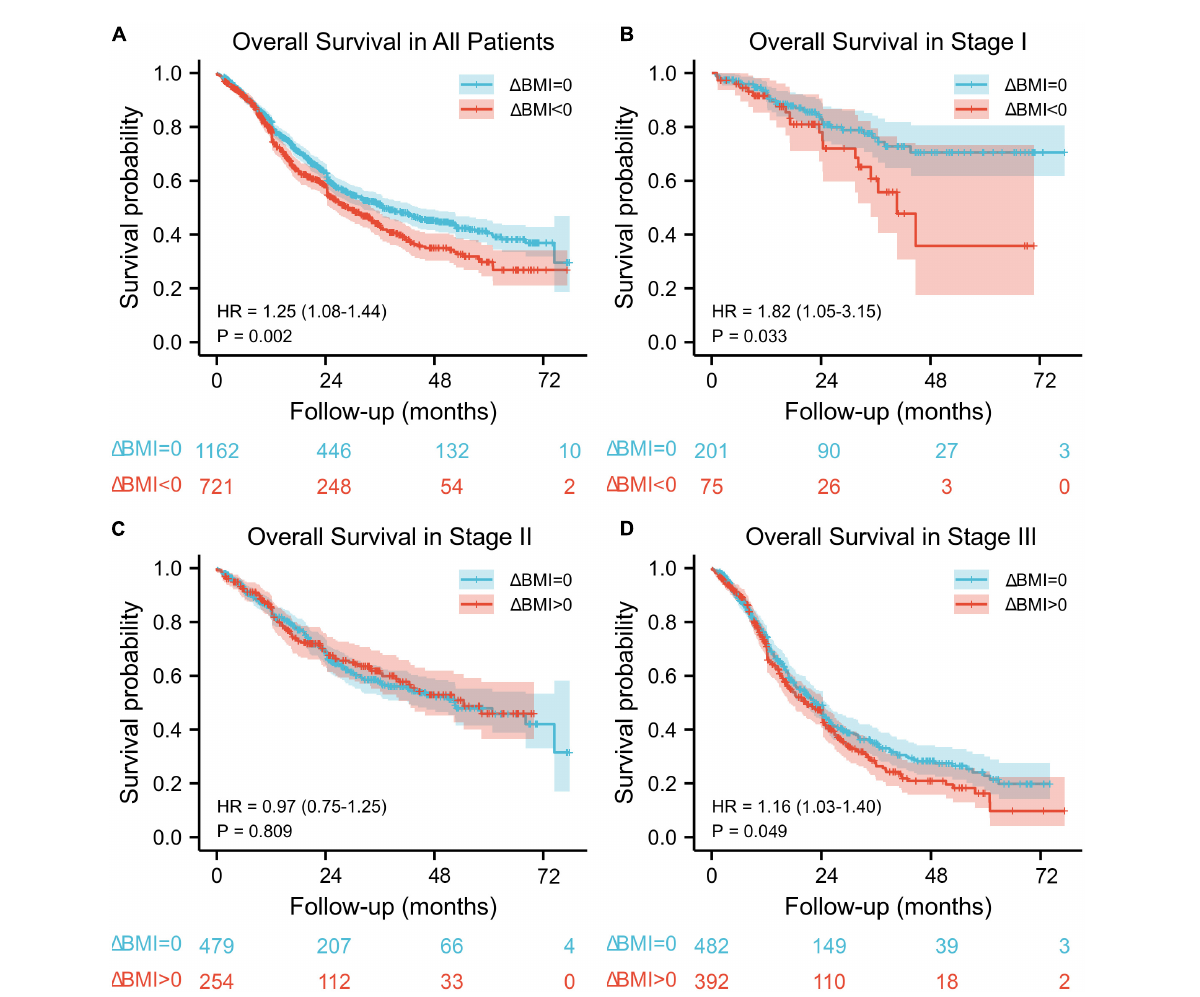
FIGURE1 Kaplan–Meier overall survival curve according to preoperative body mass index changes for all patients (A) and for stage I (B) , stage II (C) , and stage III (D) patients.